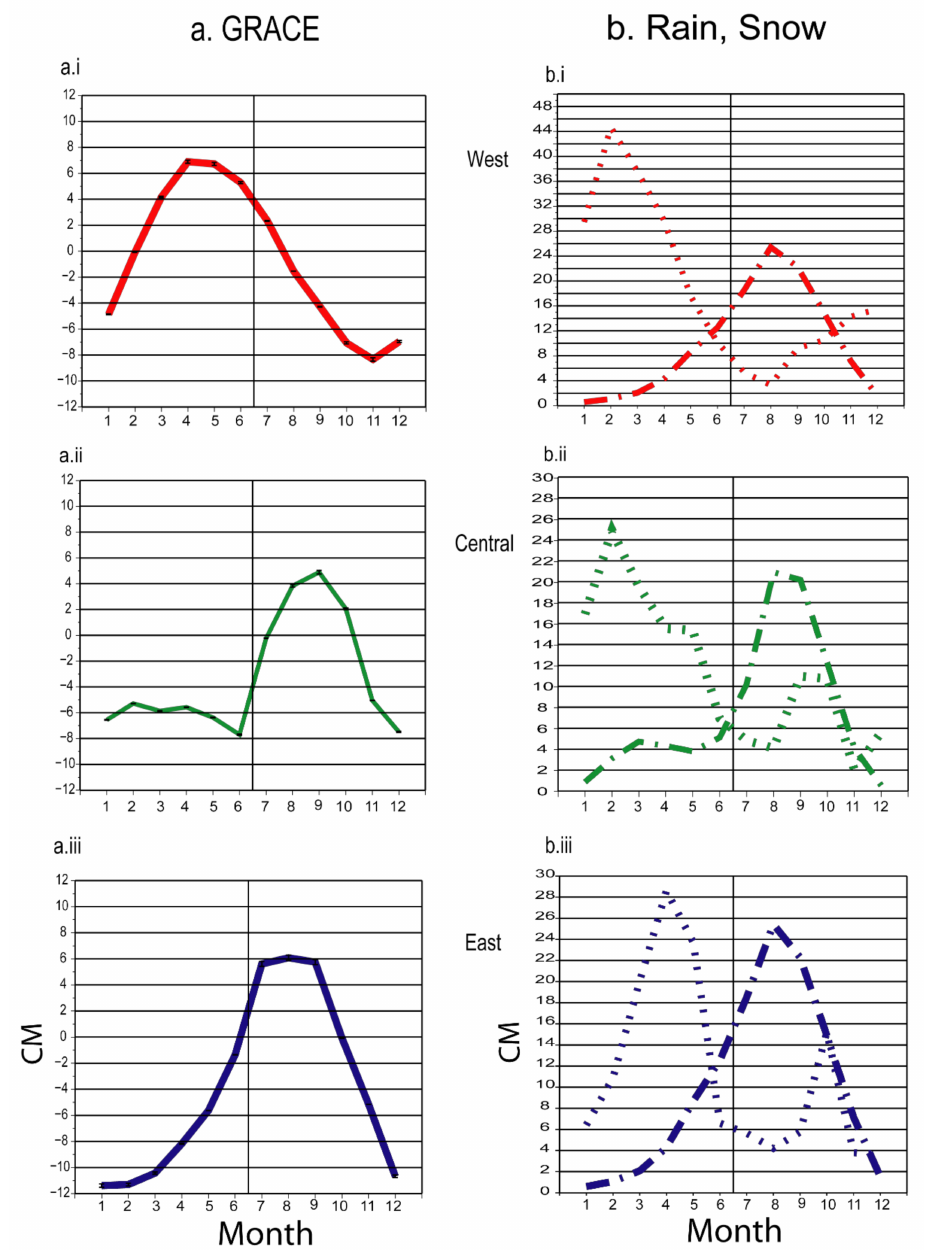
Figure 4. Seasonality of mass change across the western, central and eastern regions. Left panel ( a ) is the seasonality of GRACE data and right panel ( b ) is of rainfall (dotted line) and snowfall (dashed line). Rainfall and snowfall are in cm. In each panel (i, ii, iii) is the seasonality for west central and east Himalaya regions, as marked in Figure